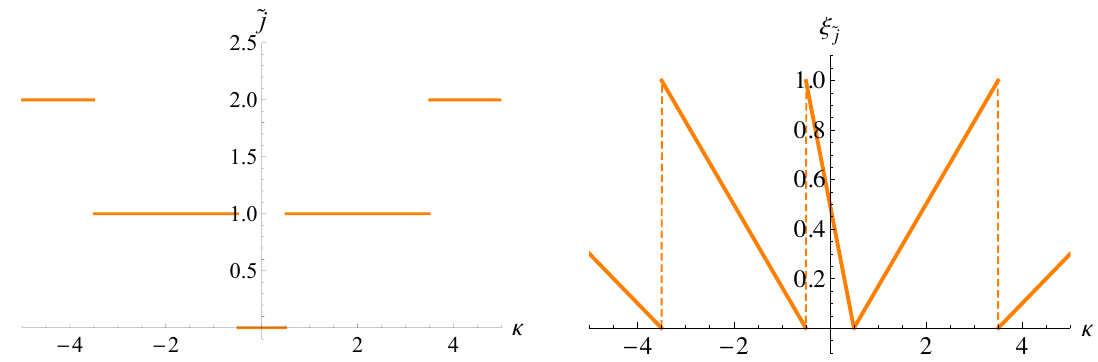
Figure 1 . The Landau level ~ j and the (cid:12)lling fraction (cid:24) ~